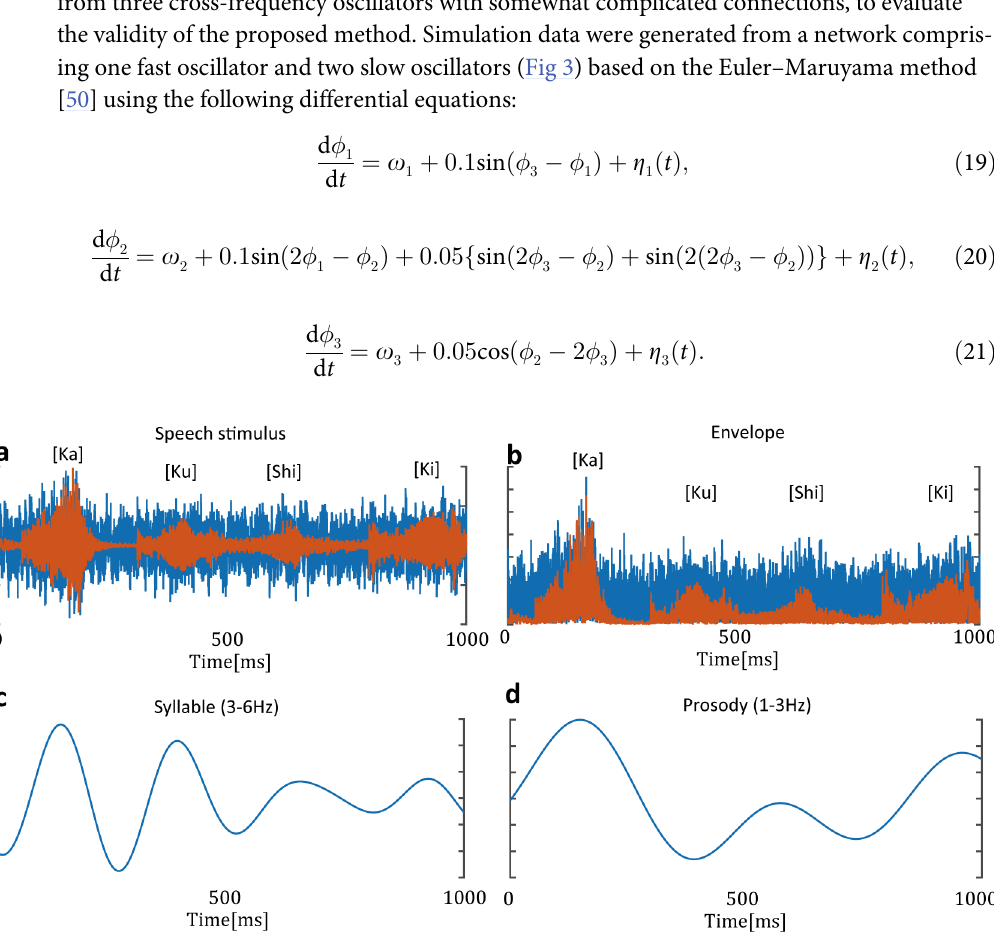
Fig 2. Syllable and prosody rhythms in speech sound. (a) Example of speech stimulus. The stimulus consisted of noise and a four-syllable Japanese word. The red line represents a speech wave. The blue line represents the presented sound wave, which consists of speech plus noise sounds. (b) Speech envelope was computed as the absolute value of Hilbert-transformed speech sound. (c) Syllabic rhythms were computed from the speech envelope through the bandpass filter within 3–6 Hz. (d) Prosodic rhythms were computed from the speech envelope through the bandpass filter within 1–3